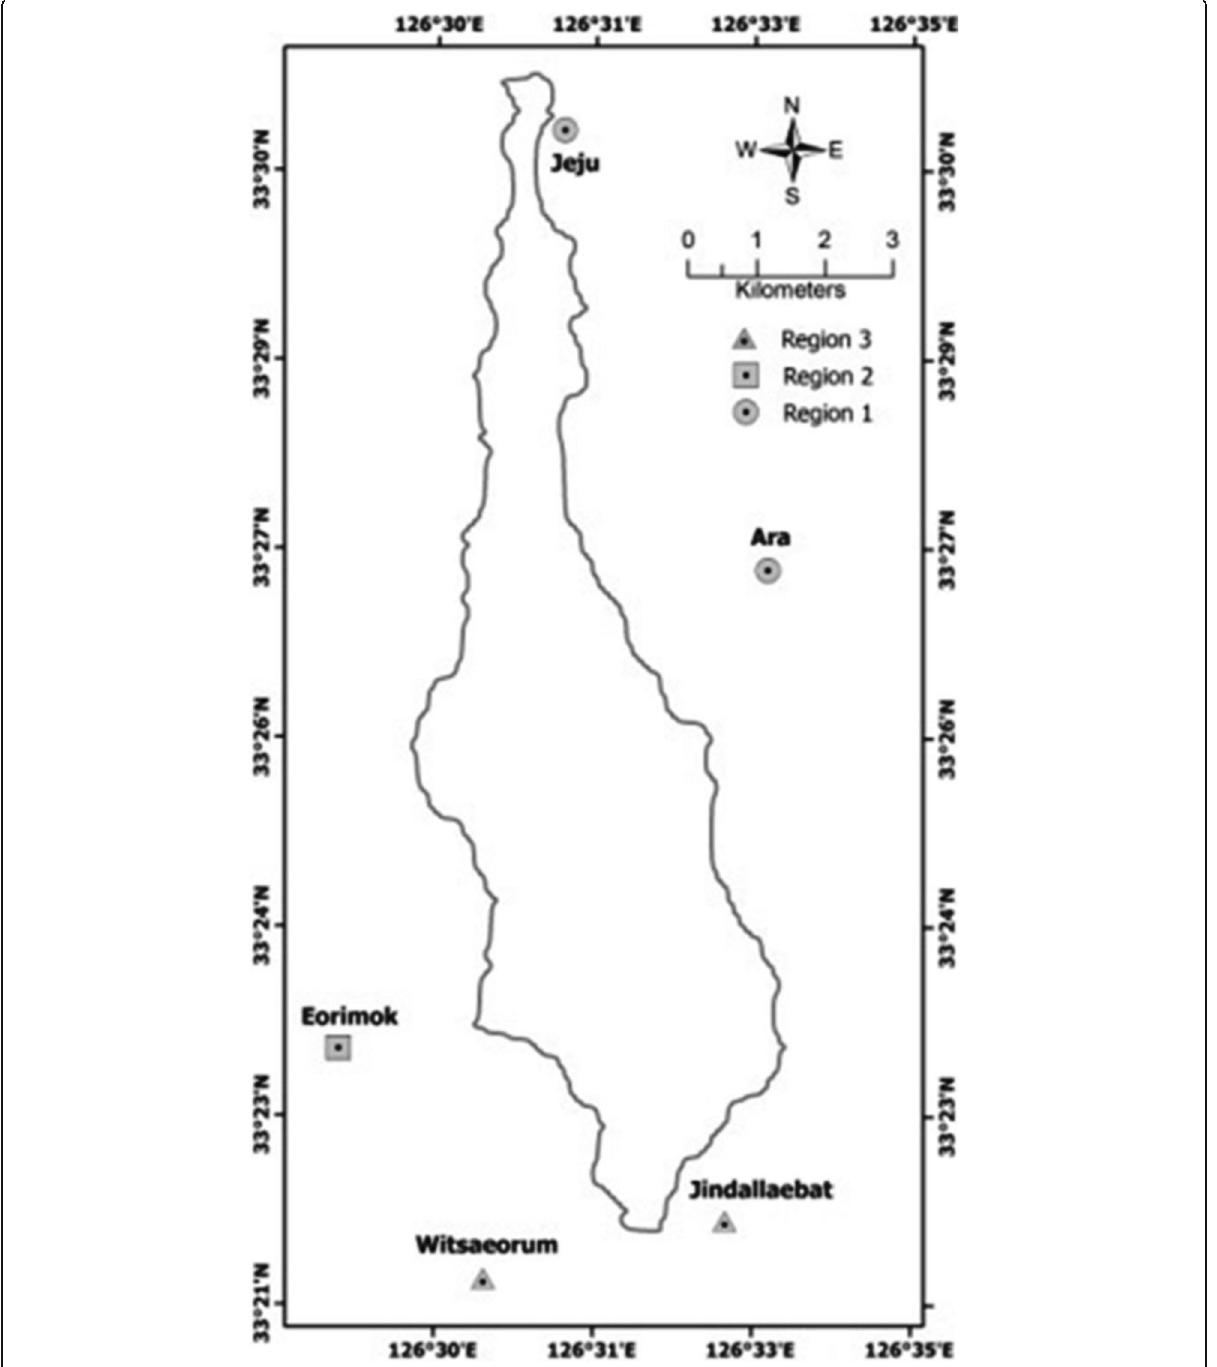
Fig. 5 Location of three homogeneous regions in Hancheon